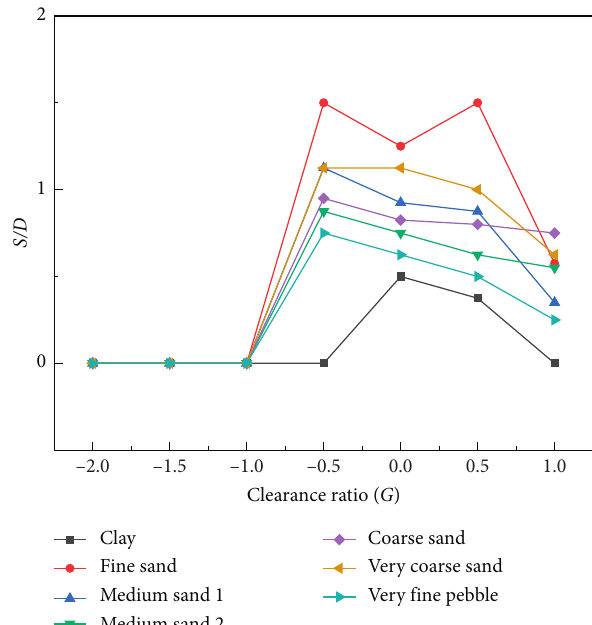
Figure 7: Variation of equilibrium scour depth with embedment ratio under different particle size riverbed conditions.